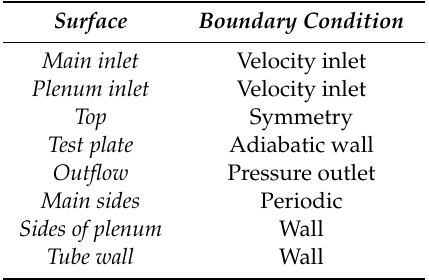
Table 1. Boundary conditions of the computational fluid dynamics (CFD)